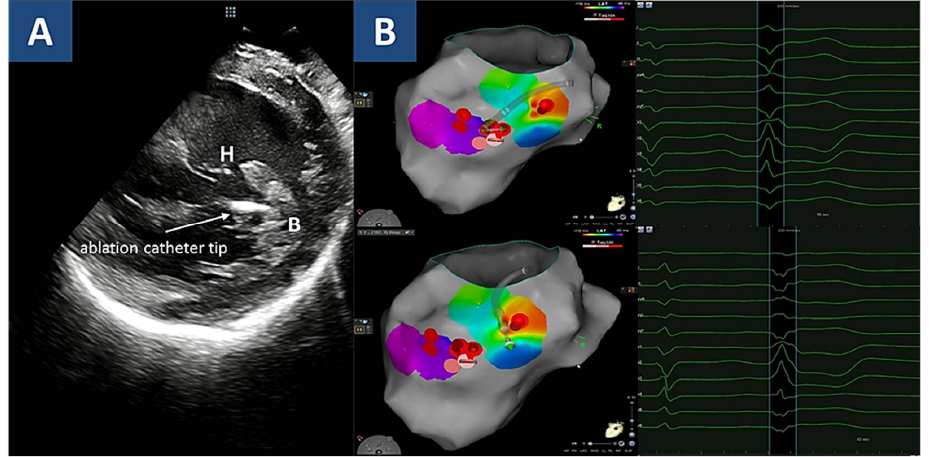
Figure 5. Mapping and ablation. Legend. A —Intracardiac echography shows the target sites for radiofrequency ablation. In particular, the most common premature ventricular complex morphology originated from the posterior papillary muscle basis (B), whereas the second one, emerging after the targeting of the basal site, arose from the head (H) of the papillary muscle. Ablation catheter tip is shown (arrow). B —activation map for both PVC morphologies is shown. Radiofrequency delivery sites appear as red dots at basis (upper panel) and head (lower panel) of the posterior papillary muscle.